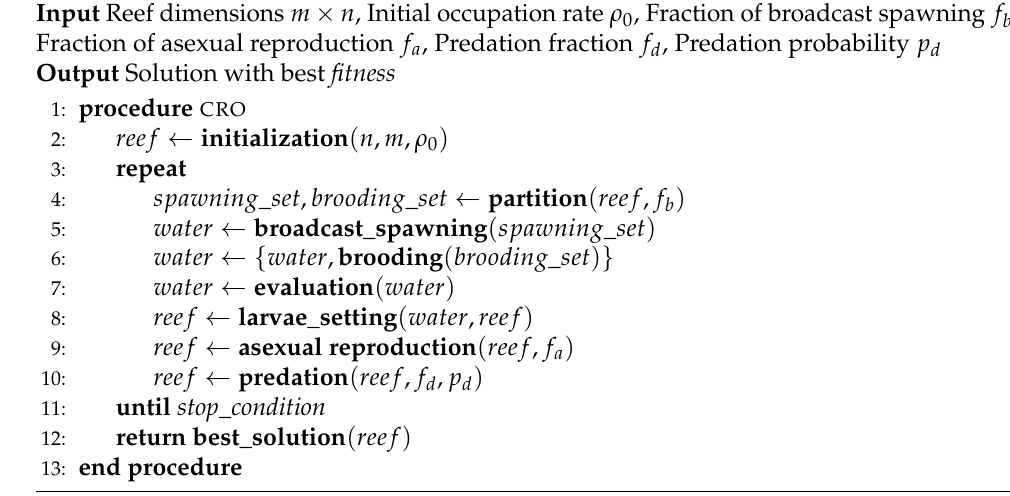
Algorithm 1 CRO algorithm pseudocode